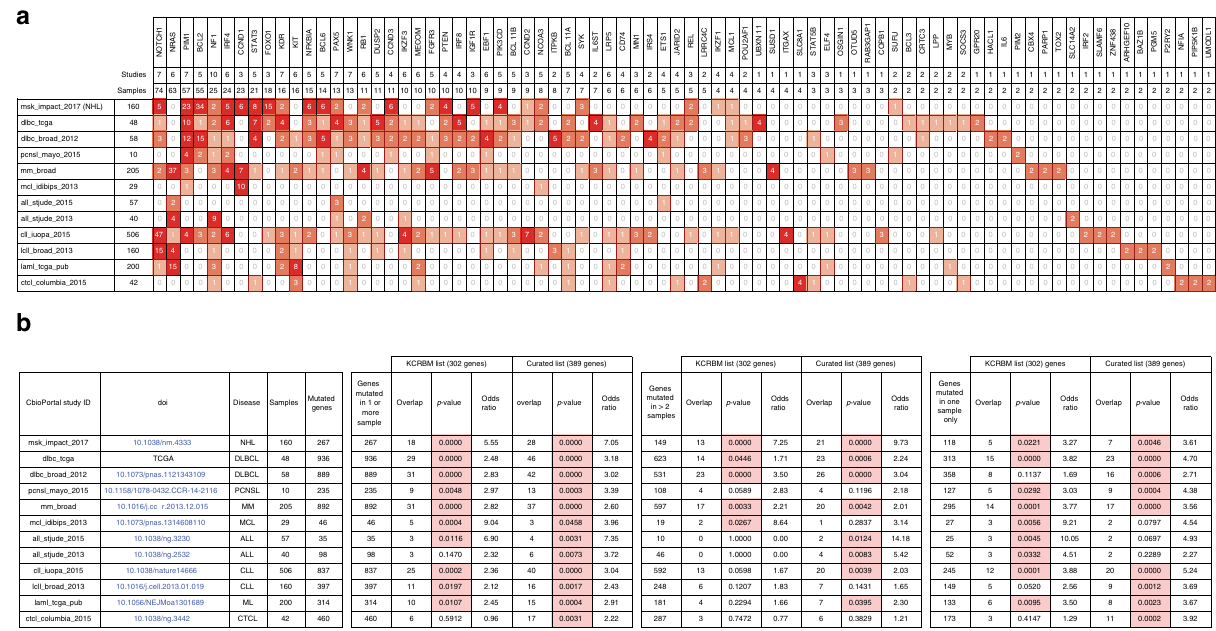
Fig. 6 Overlap of CIS loci with exome sequencing studies of hematologic malignancies. Human orthologues were identi fi ed for all candidate genes (an automated list KCRBM, and a curated list) using biomart and compared to lists of genes with coding mutations in 12 cohorts of hematologic malignancy in cBio portal. a All genes found mutated in at least two samples over all cohorts are listed with mutation counts from each cohort. The full overlap for all cohorts is listed in Supplementary Data 7. b The signi fi cance of overlap between the set of candidate orthologues and the set of mutated genes in each study is calculated using a Fisher ’ s exact transactivation activity and B lymphoma cell lines expressing subpanel of 26 BCL2 transgenic tumors. Isolated fusion transcripts were identi fi ed throughout the genome (Supplemental Data 9). The most frequent and clonal fusion transcripts identi fi ed were in the 3 ′ UTR of Mycn, causing upregulation of expression (Supplementary Fig. 12a, b and Supplementary Data 9) as observed in previous studies 31 . Another tumor had two intragenic fusions within Notch1, this tumor having the highest Notch1 expression of all 26 (Supplementary Fig. 12c, d). Insert clonality corresponds to transcript read numbers, with subclonal integrations (NC <0.1) in these tumors giving few if any detectable transcripts.